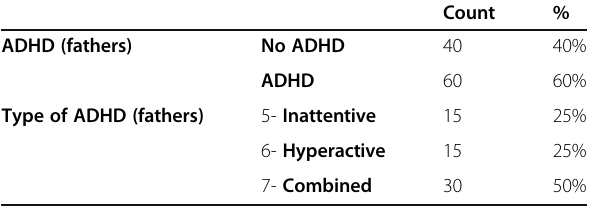
Table 1 According to Conners ’ adult ADHD rating scale, the prevalence and type of ADHD in